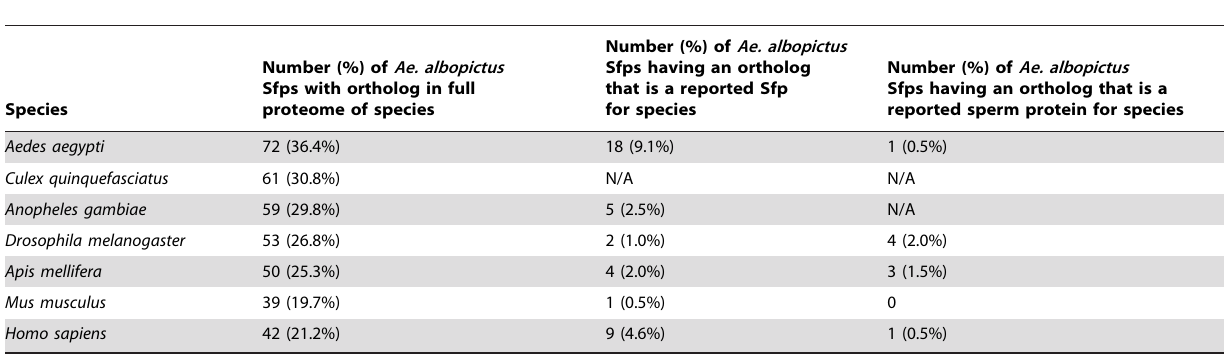
Table 2. Number of Ae. albopictus Sfps having putative orthologs in each of the seven species used for sequence similarity comparisons.